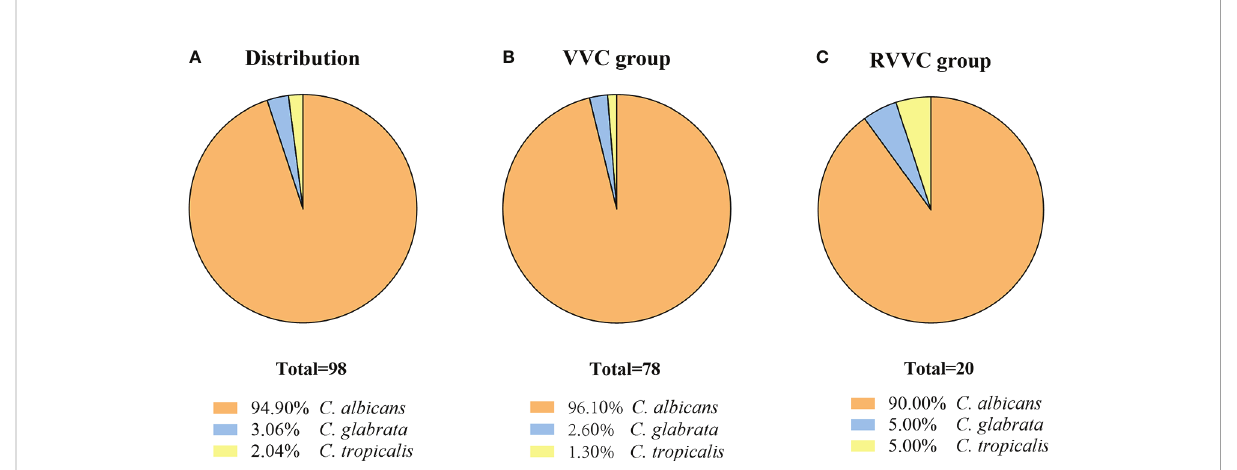
FIGURE 3 The isolates from vaginal secretion were identi fi ed by ITS sequencing. The Candida spp. distributed in both Vulvovaginal candidiasis (VVC) patients and Recurrent vulvovaginal candidiasis (RVVC) patients (A) , in VVC patients (B) and in RVVC patients (C)